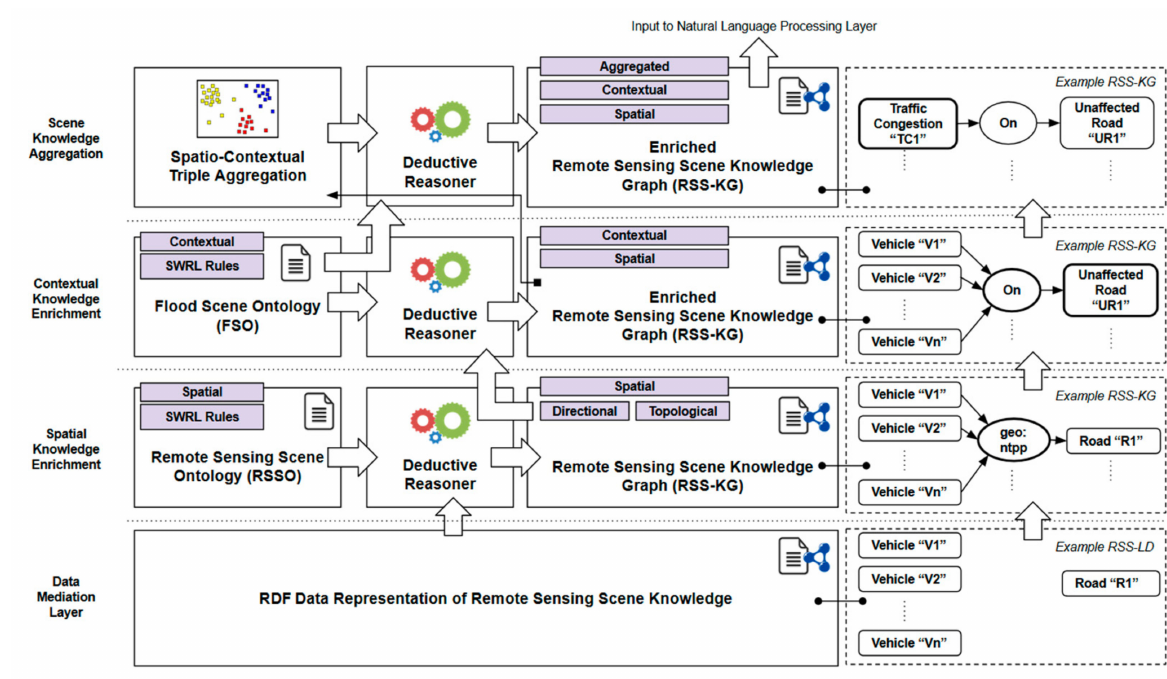
Figure 3. Multi-tier architecture of the Semantic Reasoning layer depicting semantic